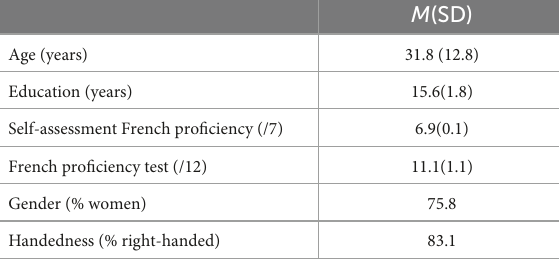
TABLE 7 Demographic data: Means ( M ) and standard deviations (SD) for N = 472 participants of Experiment